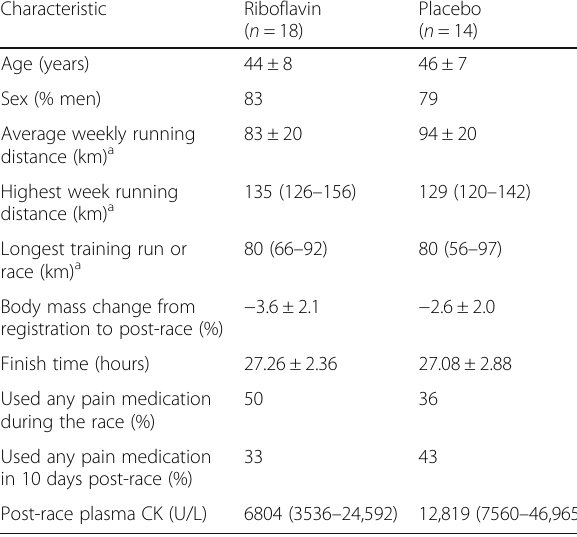
Fig. 1 Mean lower-body muscle pain and soreness ratings for the 2 groups. * p = .043 for group comparison considering only the during- race and finish data. Error bars represent 1 SD and are shown only in 1 direction for